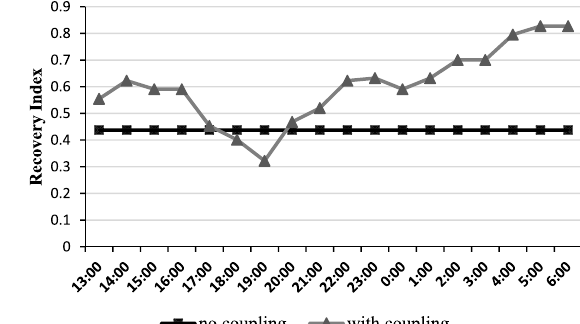
Fig. 7 MG configurations during the period